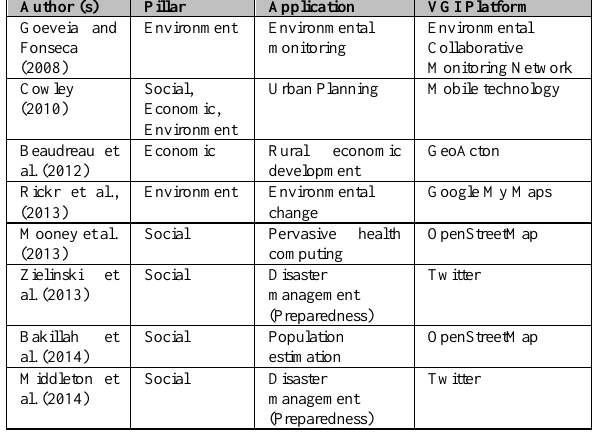
Table 1: Summary of VGI implementations in Social, Economic, and Environment